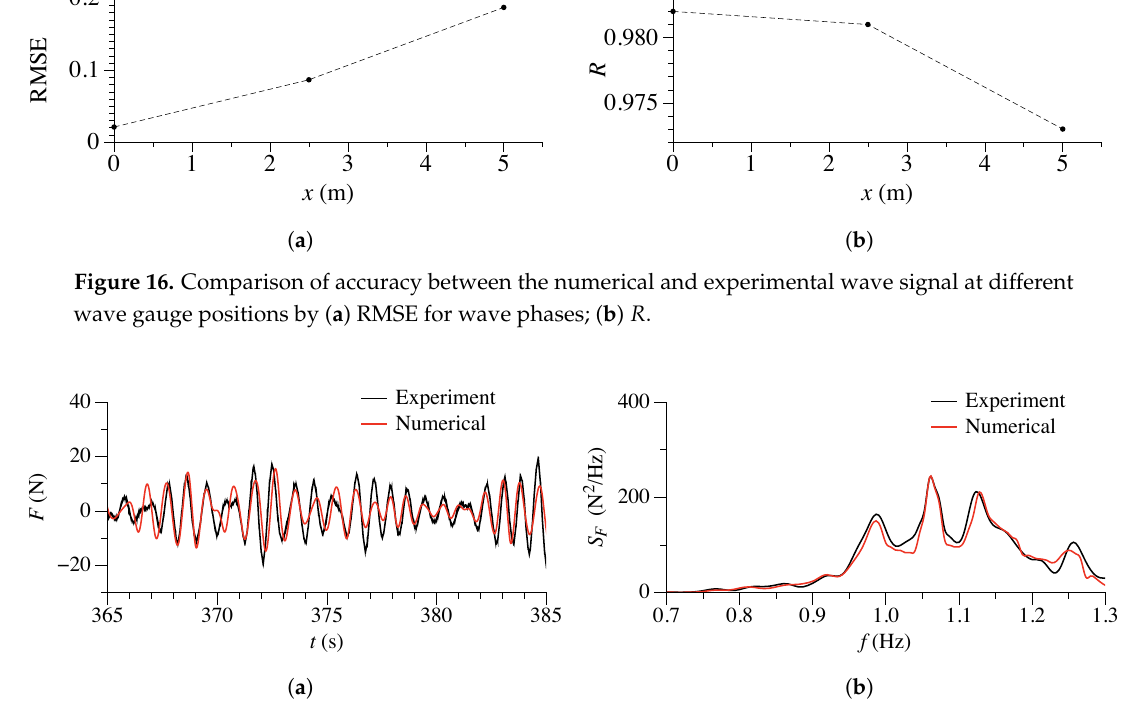
Figure 17. Comparison of the numerically reconstructed and experimental irregular wave force on the cylinder in ( a ) time-domain; ( b )